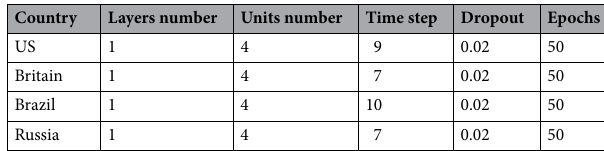
Table 3. Final determined model